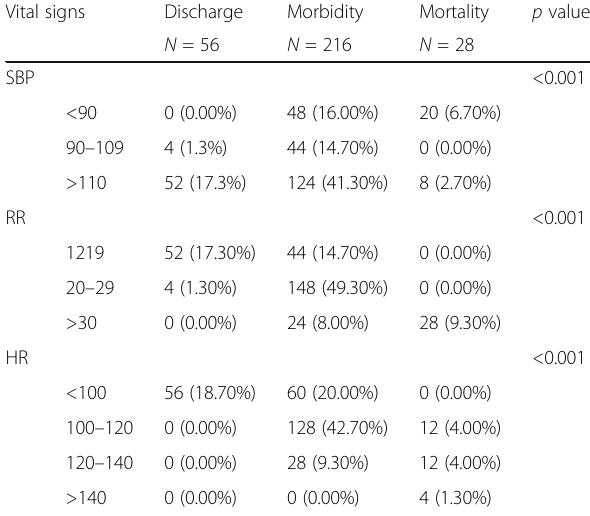
Table 2 The effect of vital signs on patients ’